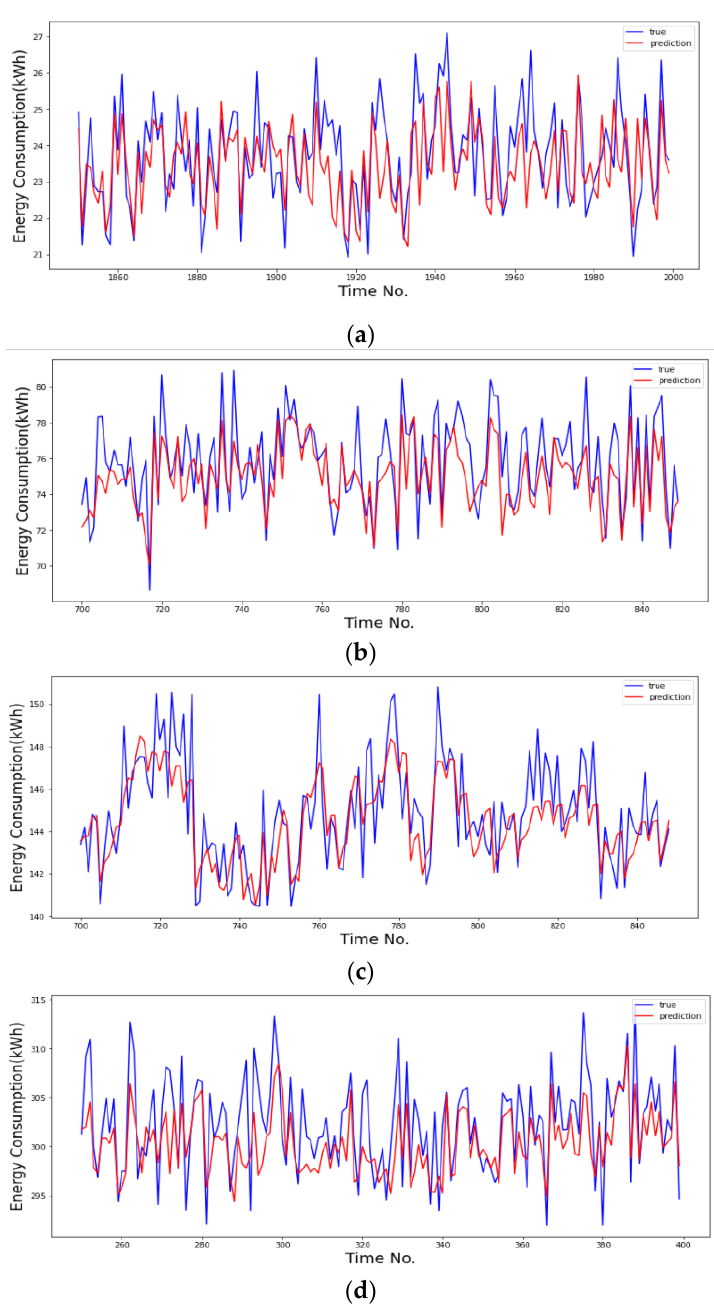
Figure 12. The continuous prediction of the STDLN for all datasets of Node EX2. ( a ) 5 min set; ( b ) 15 min set; ( c ) 30 min set; ( d ) 60 min set.